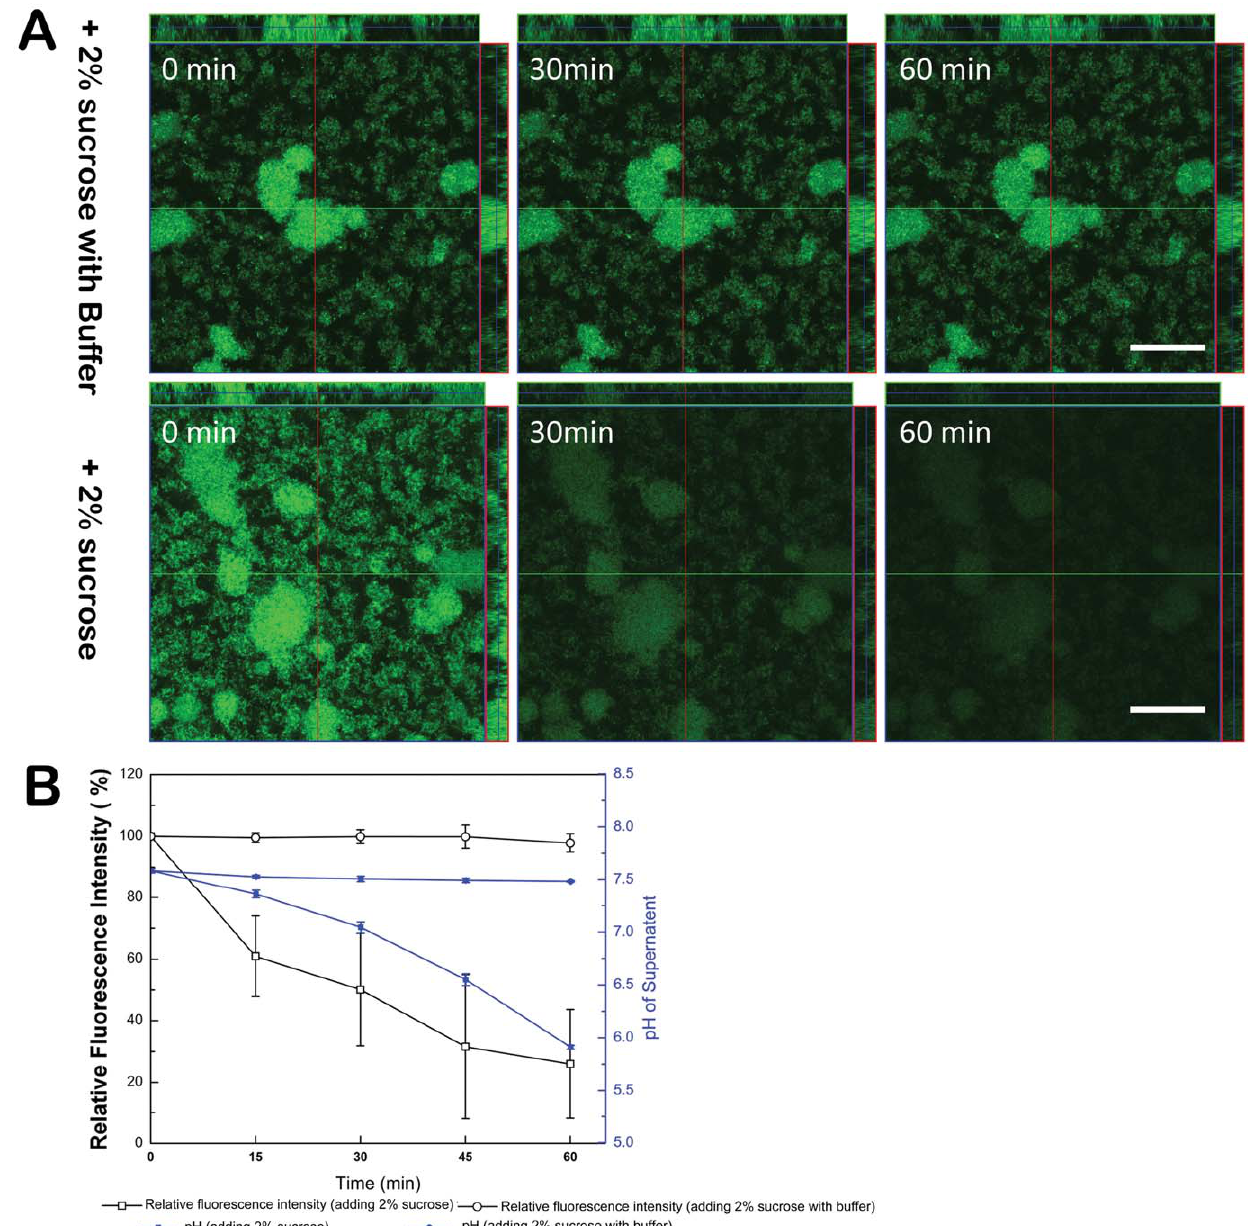
Figure 3. Temporal and spatial distribution of pHluorin fluorescent signals within S.mutans biofilms. (A) Dynamic analysis of surface- expressed pHluorin fluorescence signal changes in biofilm after addition of 2% sucrose under phosphate buffered condition (pH 7.5) (upper panel) and unbuffered condition (lower panel), respectively. (B) pHluorin signals after addition of 2% sucrose under buffered or unbuffered conditions is quantified. The proportion was calculated as the amount of pHluorin signal at each time point vs. the initial signal intensity (0 min). The plots show the average of three duplicate tests. The corresponding changes in medium pH are also included.